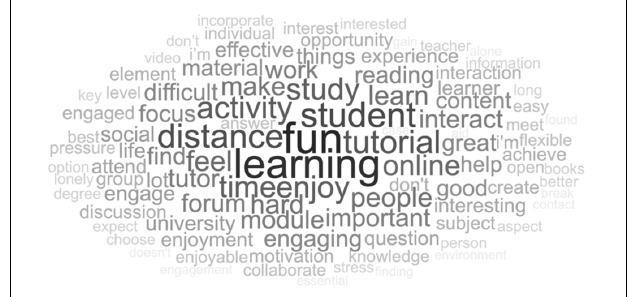
FIGURE 2 | The word cloud visualization in Qualtrics about Online Learning and